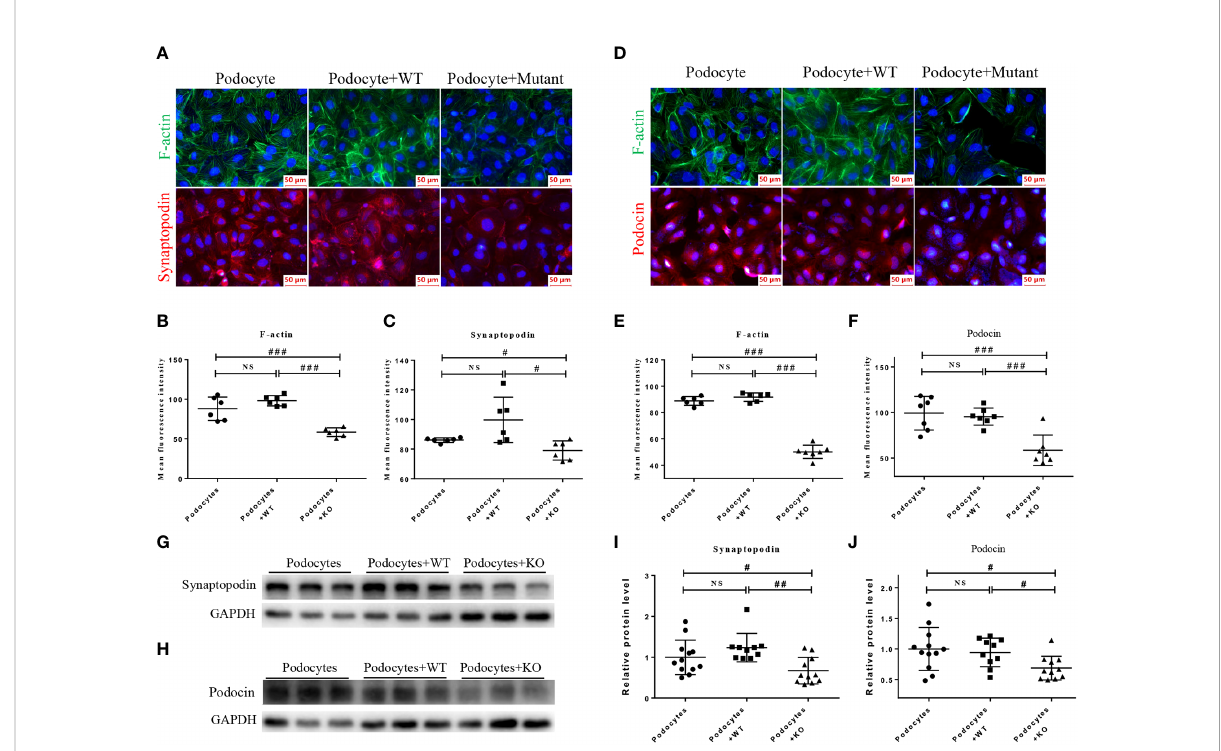
FIGURE 6 HMy2.CIR cells carrying rs6720 mutation in MDH2 caused injury to podocytes. (A – C) Representative pictures and quanti fi cation of immuno fl uorescence staining of F-actin (green), synaptopodin (red) and DAPI (blue) in podocytes before and after WT or mutant HMy2.CIR cell exposure. (D – F) Representative pictures and quanti fi cation of immuno fl uorescence staining of F-actin (green) and podocin (red) in podocytes before and after WT or mutant HMy2.CIR cell exposure. Six random fi elds were taken from each coverslip (mean ± SD, n=6). Scale bar: 50um. Western blot and statistics for Synaptopodin (G, I) and Podocin (H, J) from podocytes before and after WT or mutant HMy2.CIR cell exposure (mean ± SD, n=9-12). # p < 0.05; ## p<0.01; ### p<0.001; NS, no signi fi